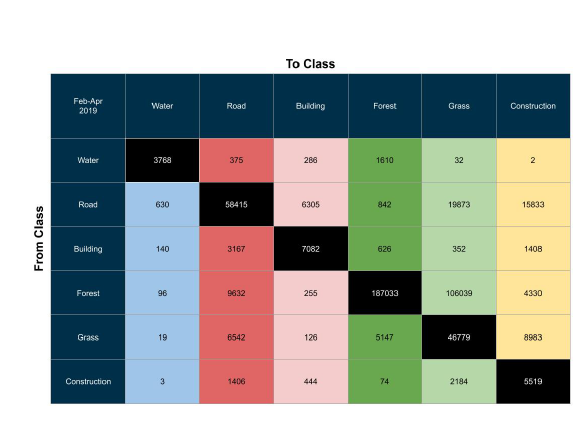
Figure 7: Thematic (from-to) changes from the classification out- puts of random forests ran on images from February 2019 and April 2019.